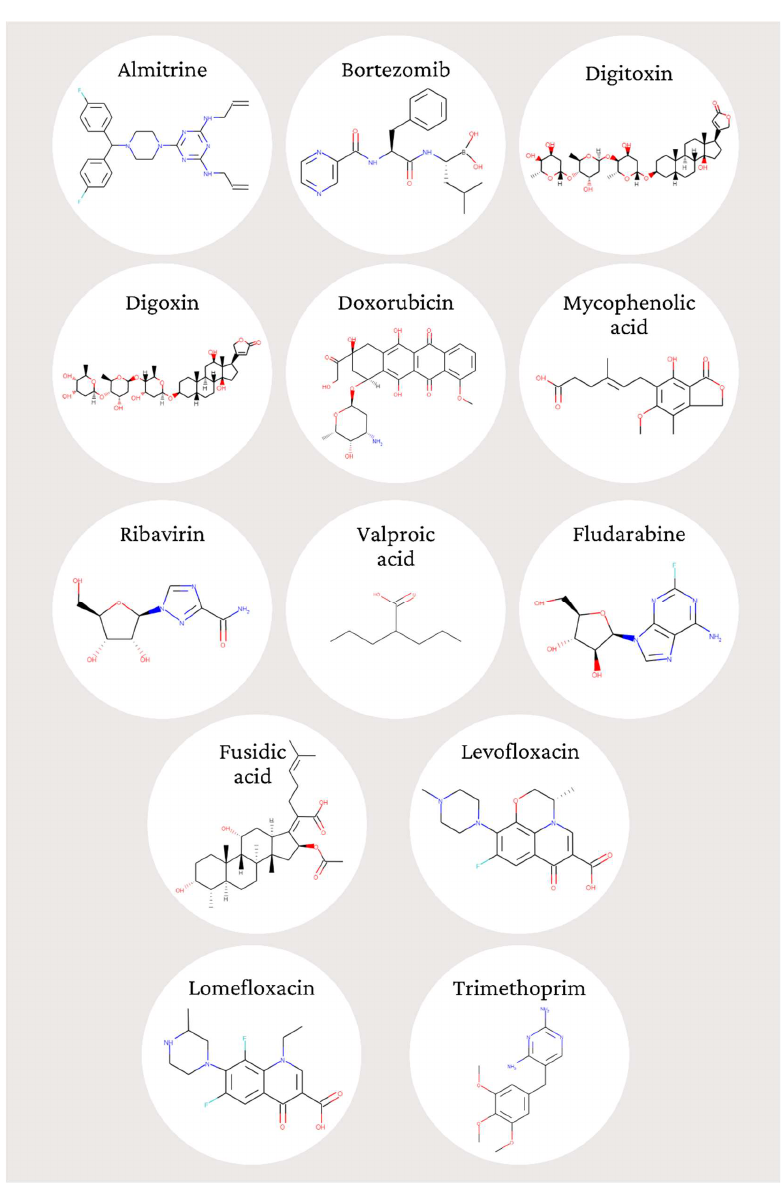
Figure 2. Structures of the 13 compounds tested against T. gondii in vitro. The structures were obtained from http://www.ebi.ac.uk/chembl. We used a 96-well plate assay based on β-galactosidase expression to estimate the T. gondii tachyzoites’ viability. From the 13 tested compounds, three demonstrated anti- T. gondii activity at nanomolar range, named almitrine (MMV1804175), bortezomib (MMV009415), and fludarabine (MMV637413), with activity comparable to the reference